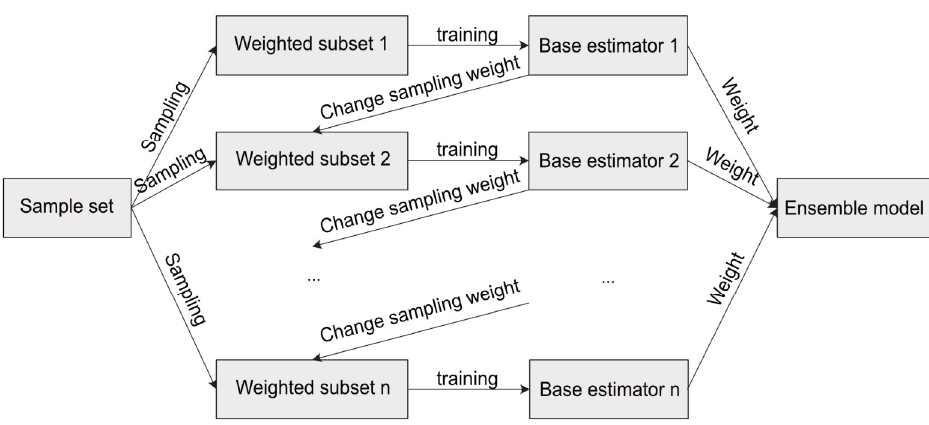
Figure A2. Workflow of AdaBoost model. Sampling weight is adjusted after every iteration and final decision is made by weighted average.